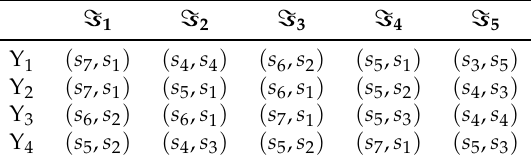
Table 2. Decision matrix Q 2 by Z 2 .